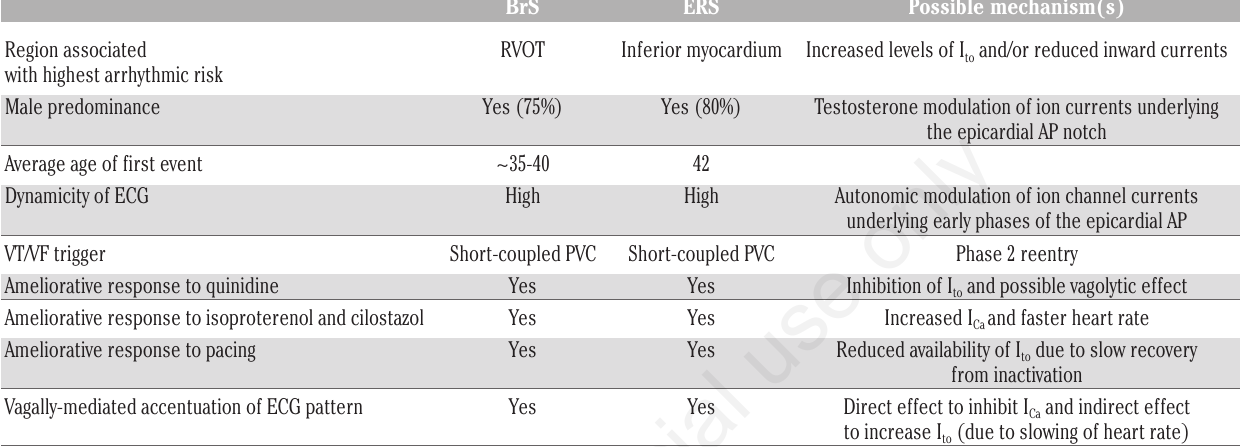
Table 1. Features common to Brugada and early repolarization syndromes and possible underlying mechanisms.